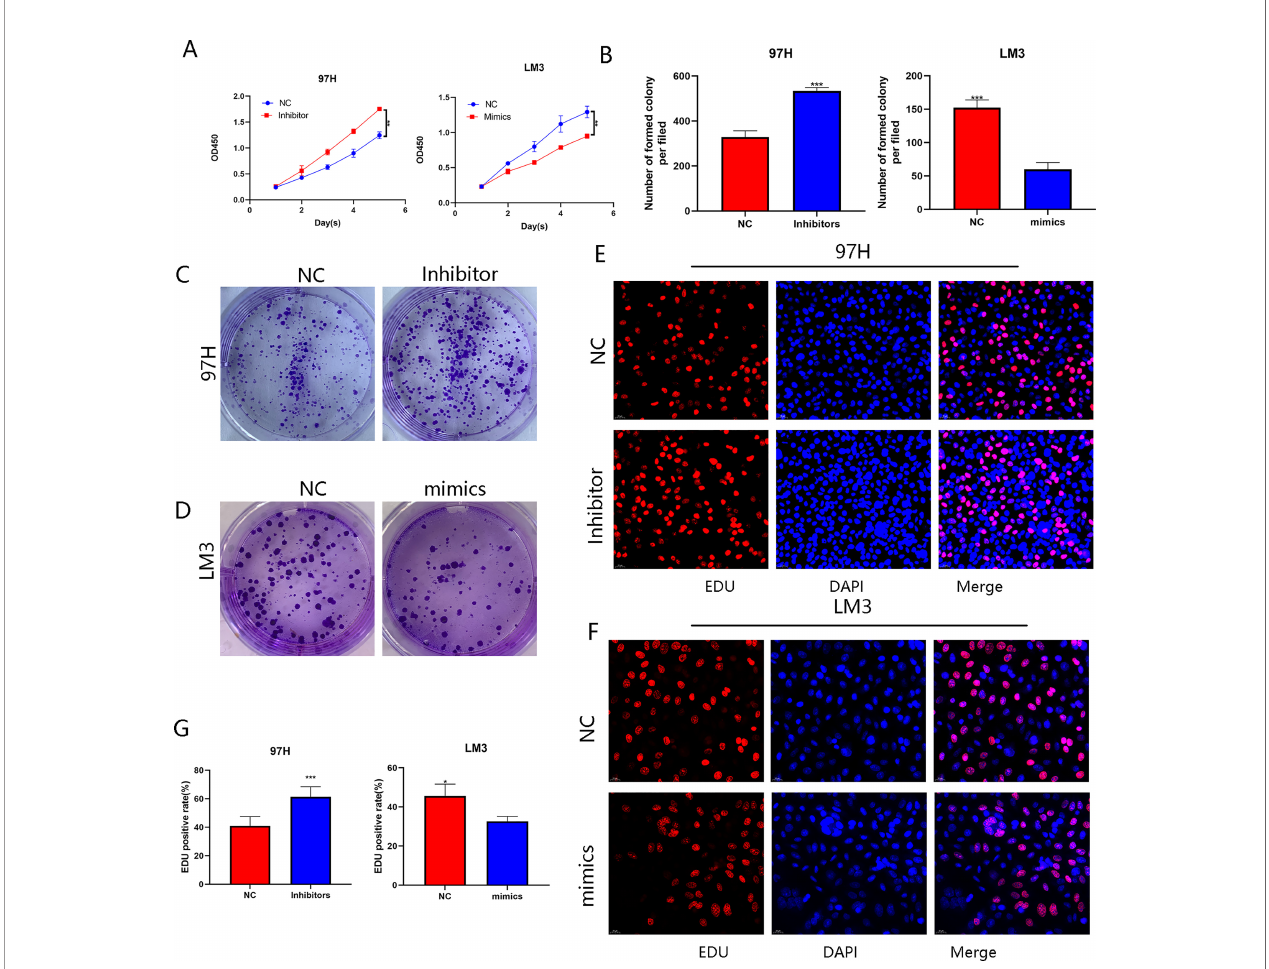
FIGURE 5 | miR-1263 inhibits the proliferation of HCC cells. (A) CCK-8 assay of LM3 and 97H cells transfected with mimics or an inhibitor. (B – D) Effect of mimics or an inhibitor on the proliferation in HCC cell lines as determined by the colony formation assay. (E – G) EDU assay of LM3 and 97H cells treated with mimics or an inhibitor. (* p < 0.05, ** p < 0.01, *** p <